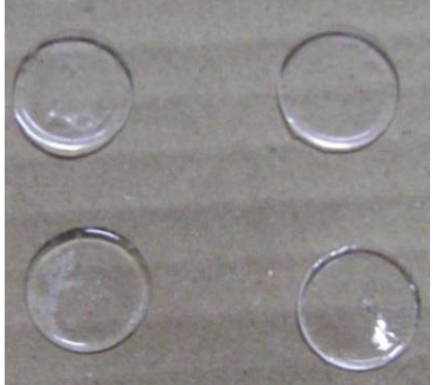
Figure 3: SiO monoliths obtained by sol-gel technique. 2